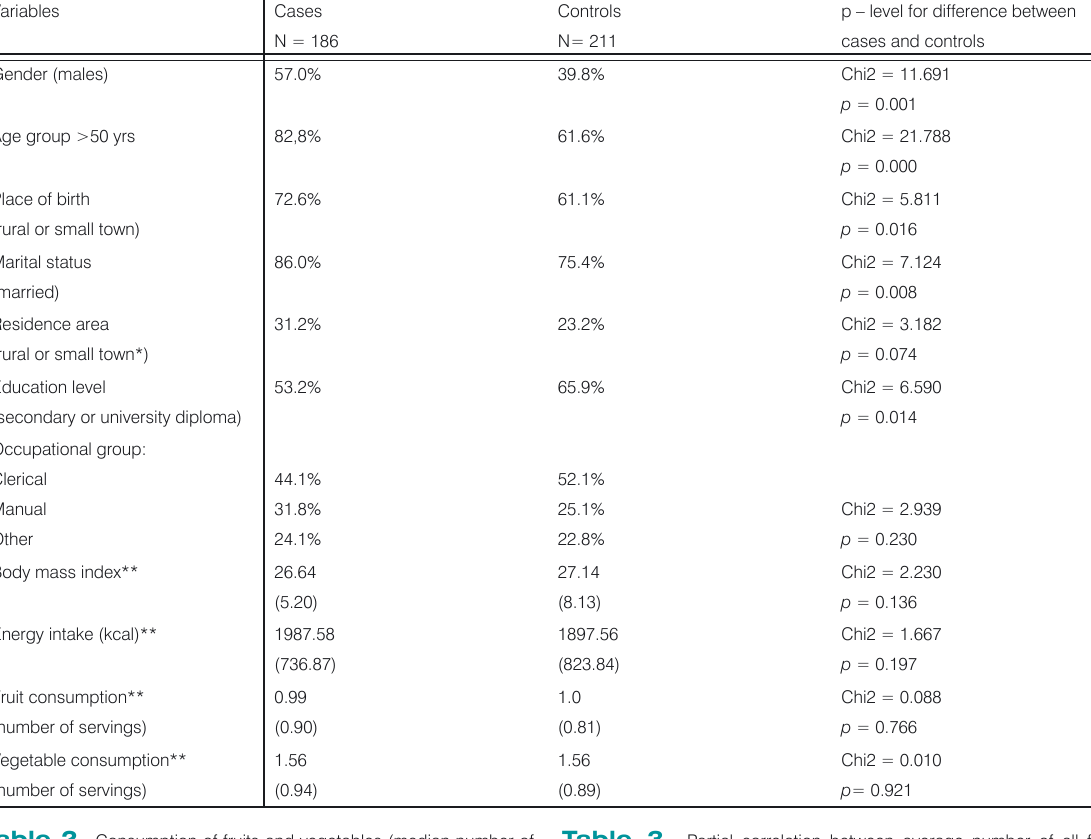
Table 1. Characteristics of the study population.